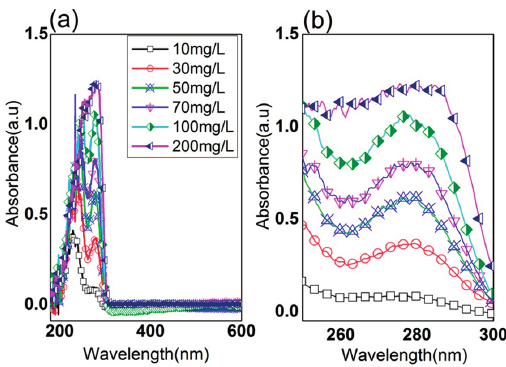
Figure 2. ( a ) UV-Vis spectra of water samples with different potassium hydrogen phthalate (KHP) concentrations; and ( b ) the magnified absorbance spectra in UV